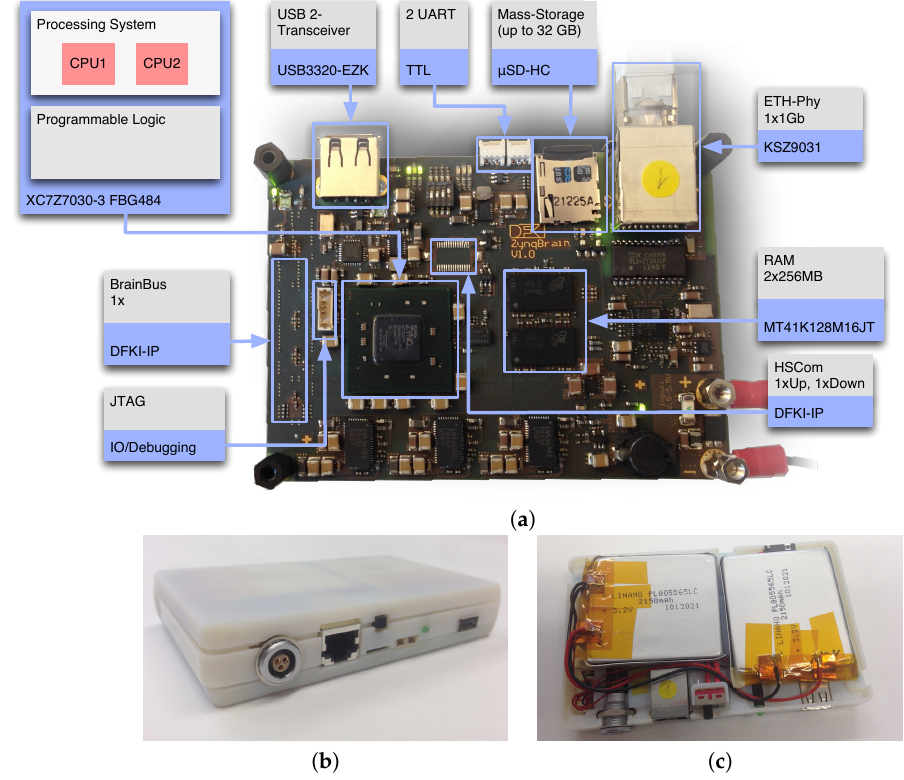
Figure 1. The ZynqBrain processing platform: ( a ) printed circuit board; ( b ) assembled system with 3D-printed cover; ( c ) battery